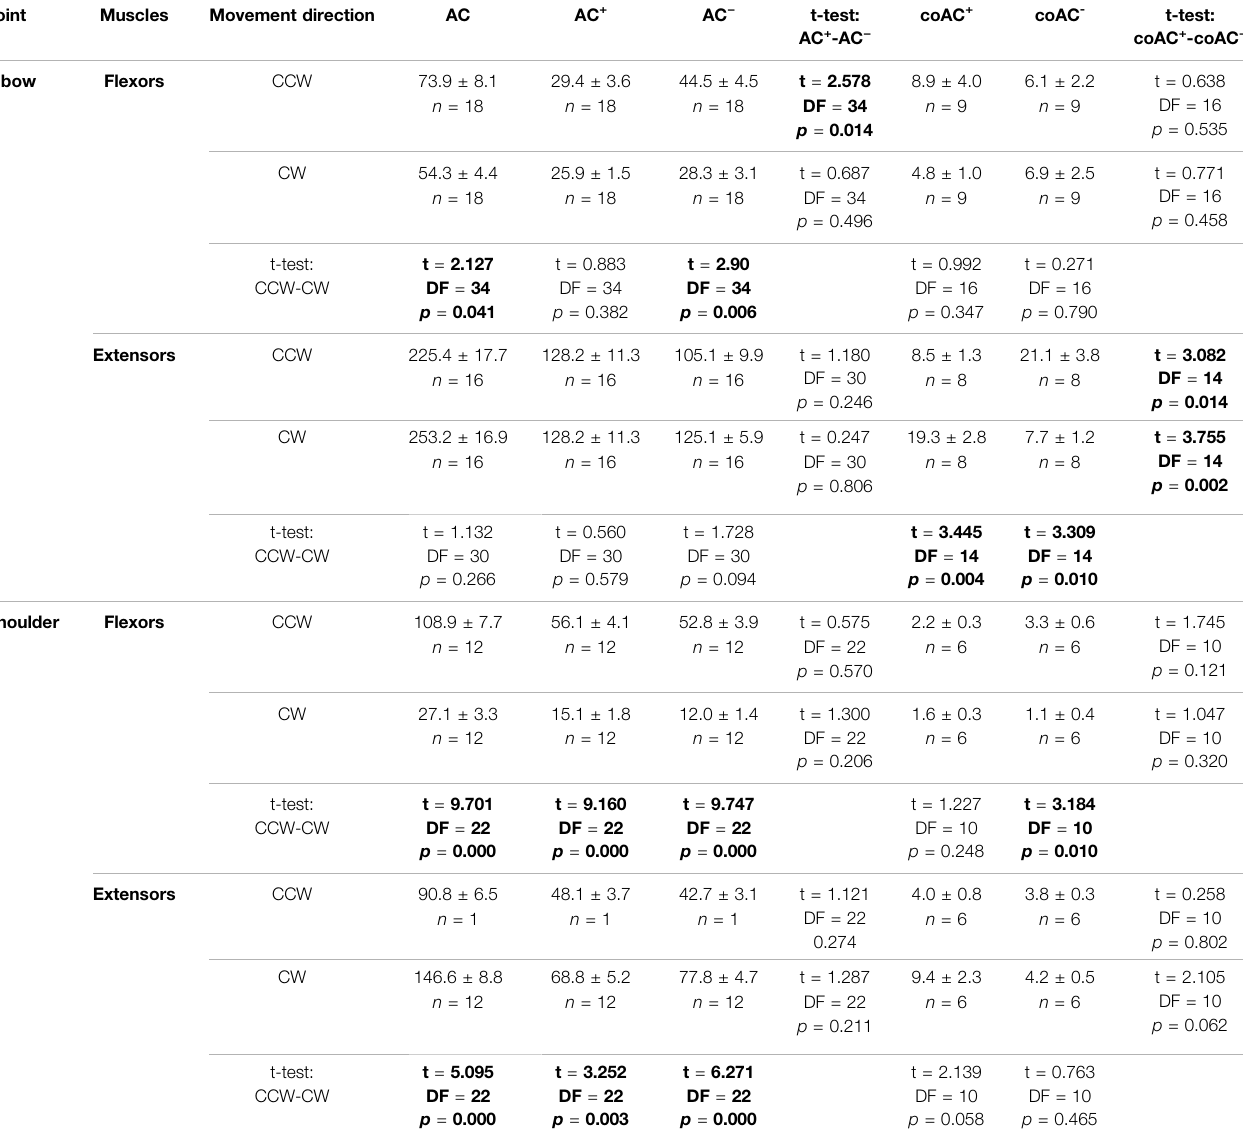
TABLE 1 | Statistical analysis of the average EMG components recorded in four different experiments on a subject YK with identi fi ed bone geometry. Joint Muscles Movement